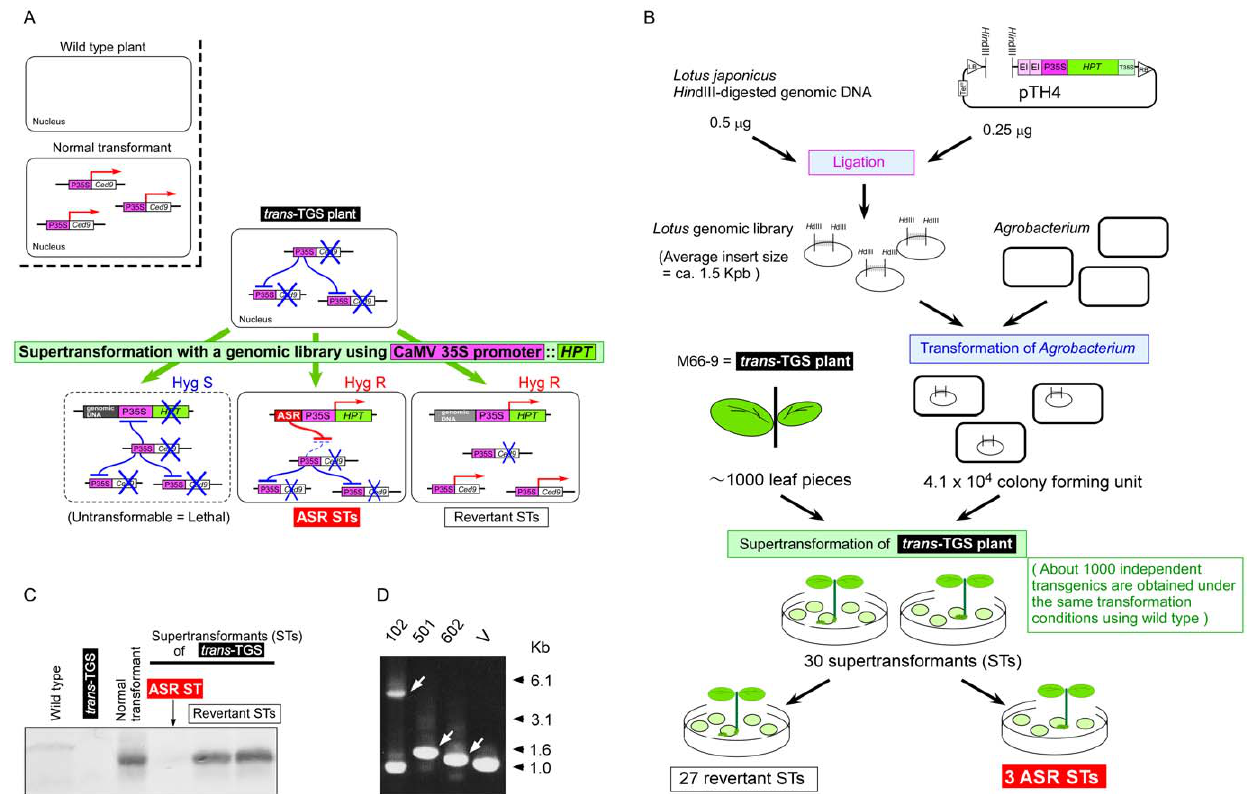
Figure 1. Identification of anti-silencing regions (ASRs) preventing transcriptional gene silencing (TGS): strategy to screen ASR candidates from a genomic DNA library. ( A ) Schematic diagram depicting strategies to select ASRs using a transgenic tobacco plant possessing trans -TGS activity. The Xs indicate that the transgenes are silenced. ( B ) Isolation of anti-silencing region (ASR) candidates. DNA elements that would have ASR activity were isolated from regenerated supertransformants of the trans -TGS plant (see also A ). Under the same conditions of